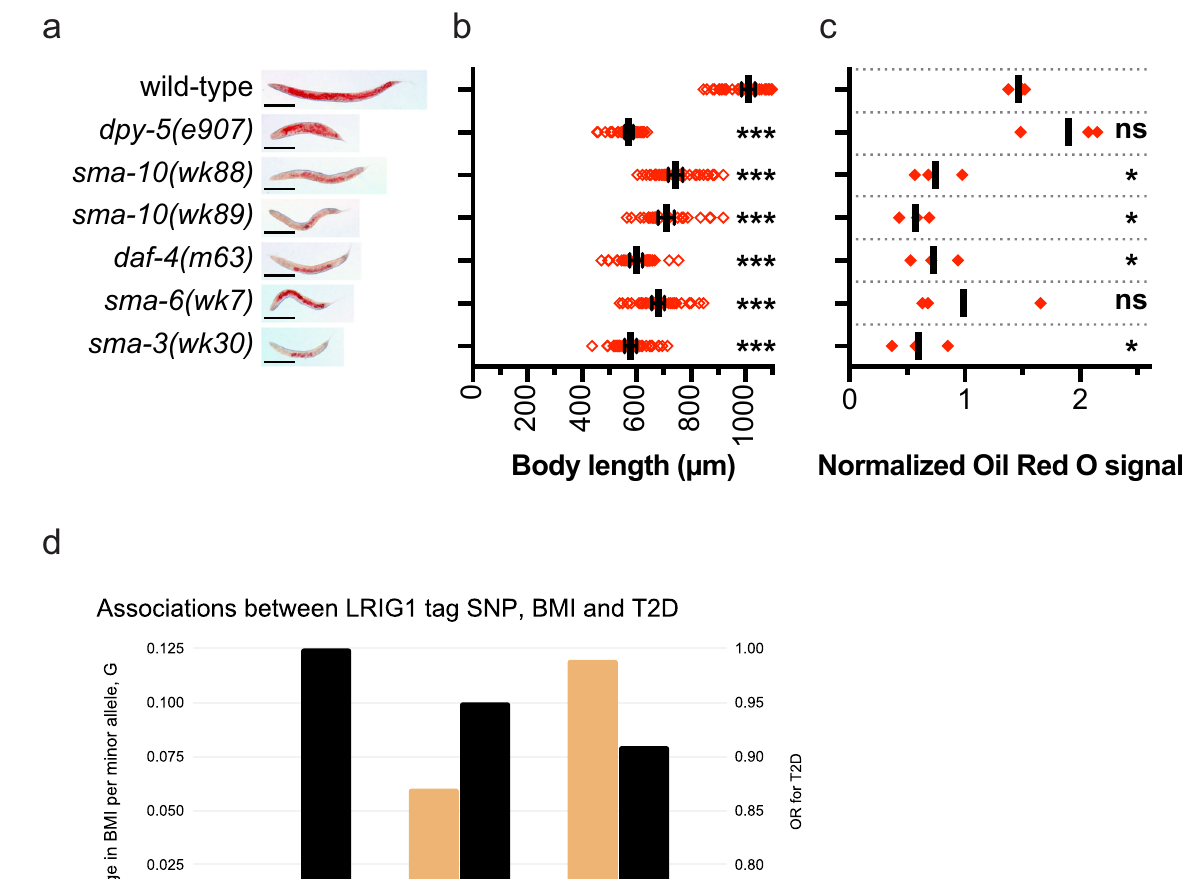
Fig. 6 LRIG/sma-10 and other BMP pathway genes promote lipid accumulation in lipid-storing cells in C. elegans , and LRIG1 SNPs predict BMI and type 2 diabetes in humans. a Representative whole-body images of Oil Red O-stained adult hermaphrodite worms. Scale bars, 200 μ m. b Adult body lengths of wild-type animals ( n = 46), dpy-5(e907) ( n = 37), sma-10(wk88) ( n = 41), sma-10(wk89) ( n = 32), daf-4(m63) ( n = 32), sma-6(wk7) ( n = 41), and sma-3 (wk30) ( n = 37). The body length of each individual animal is plotted as a red square. Solid lines and error bars indicate the means and 95% con fi dence intervals, respectively. The order of the dot plots, from top-to-bottom, is the same as that for the images in a . c Oil Red O signal intensities from three independent experiments. Each experiment was normalized to its combined mean signal intensity across all genotypes. For each genotype, solid, red squares indicate the mean normalized signal in each independent experiment. Solid lines indicate the combined means from three experiments. The order of the dot plots, from top-to-bottom, is the same as those for the images in a. Statistical signi fi cance versus wild-type was determined with multiplicity-adjusted P -values, calculated using Holm-Sidak multiple comparisons tests. * P < 0.05, *** P <0.001. d Plot illustrating the difference in predicted BMI (least square means, LSMs) across the genotypes of rs4856886 (minor allele = G, major allele = T) and odds ratio for type 2 diabetes (T2D) across genotypes. The x -axis represents the rs4856886 genotypes compared. The y -axis on the left represents the difference in BMI LSMs per single minor allele across the genotypes, while the y-axis on the right represents the odds ratios for T2D. In this study, the minor allele was associated with an increase in BMI and a lower odds of T2D